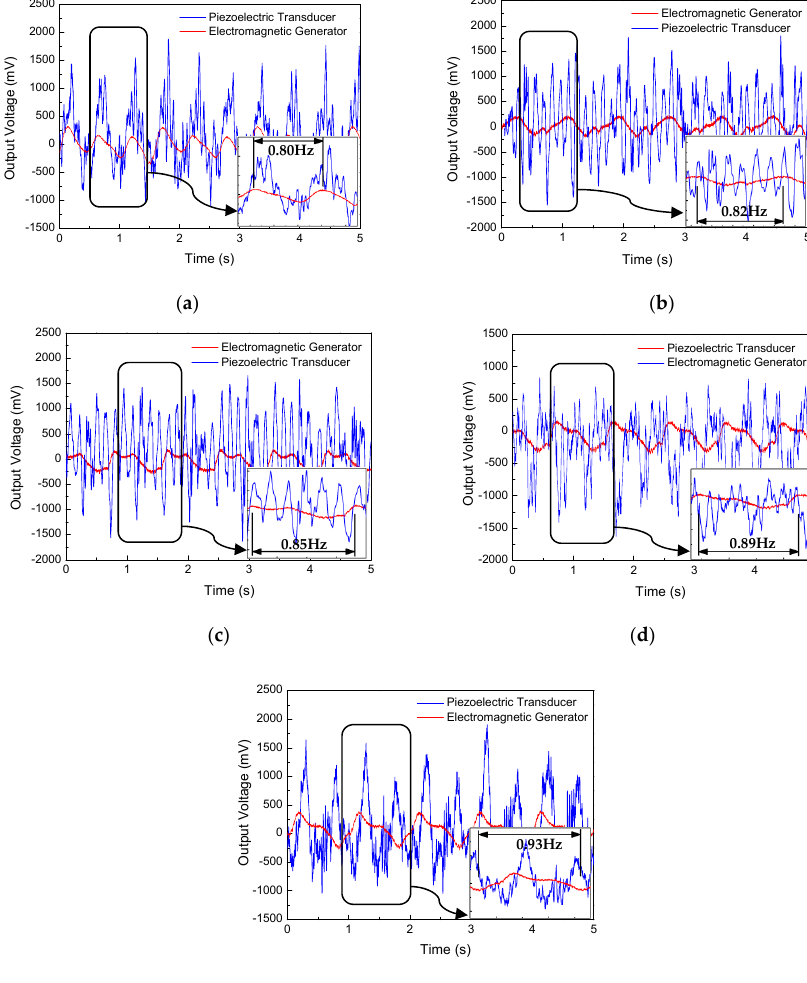
Figure 4. Output voltage signals of the hybrid energy harvester with different liquid levels: ( a ) h = 40 mm; ( b ) h = 60 mm; ( c ) h = 80 mm; ( d ) h = 100 mm; and ( e ) h = 120 mm.